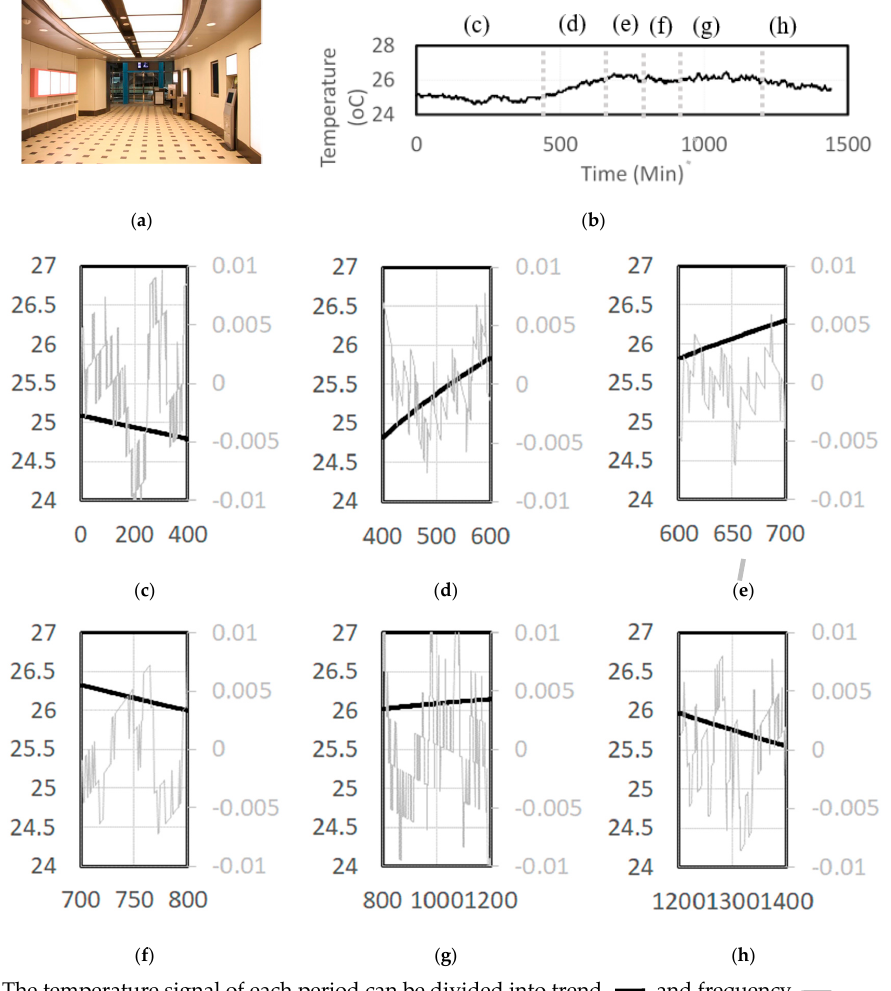
Figure 4. Big data collection for the PIN sensor design and AI control performance test: ( a ) a sample